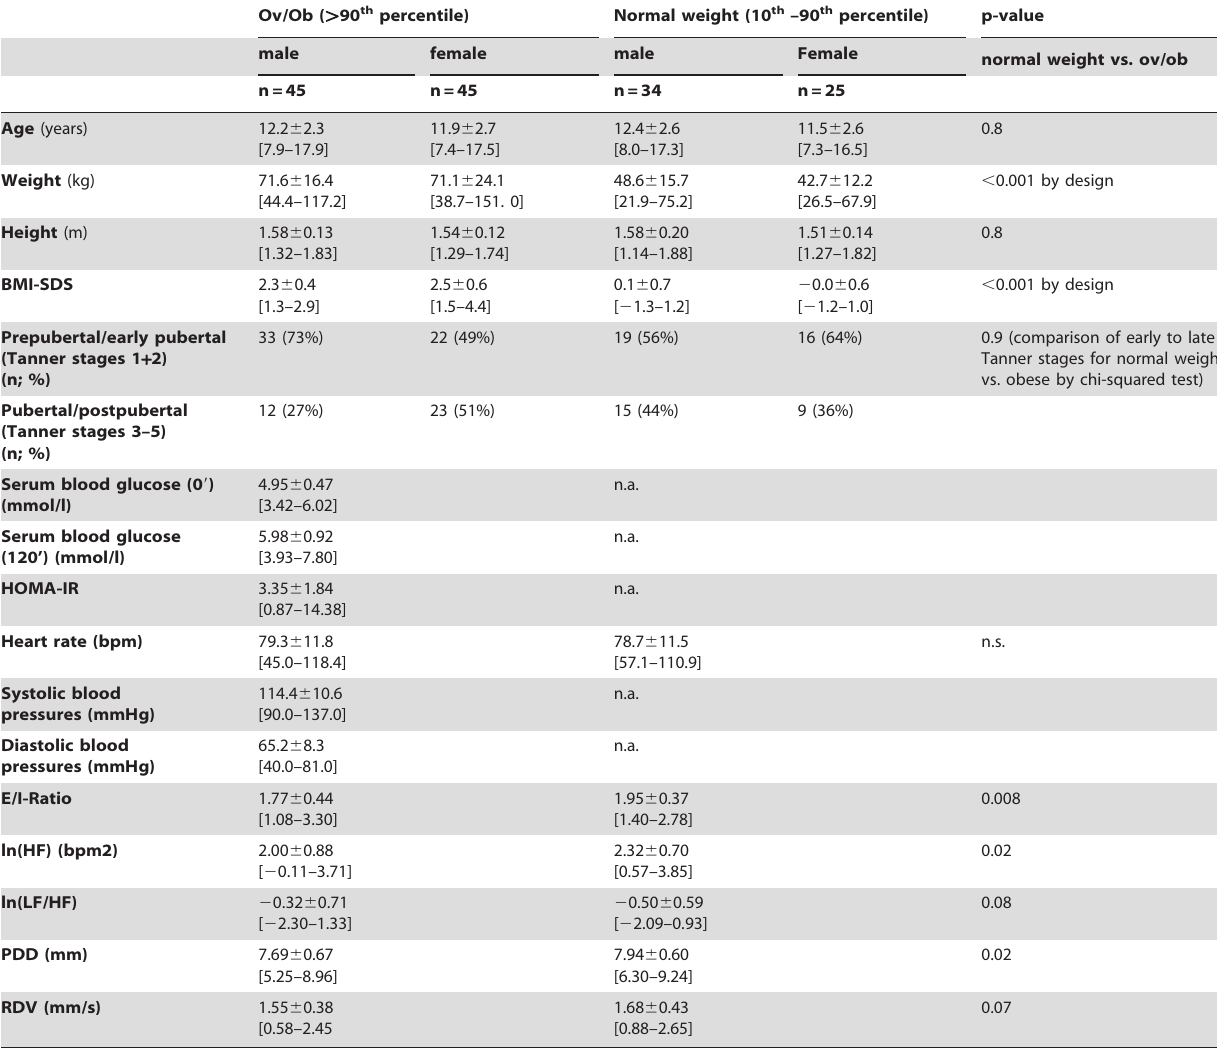
Table 1. Characteristics of study